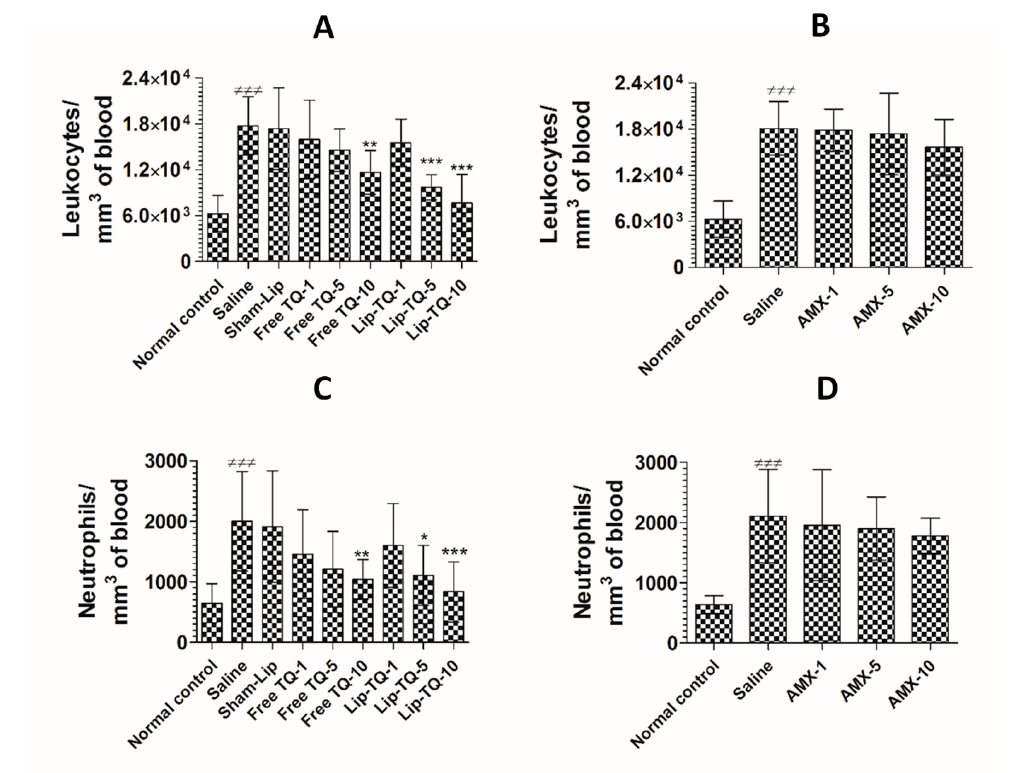
Figure 10. Treatment with Lip-TQ, but not with AMX, alleviated the parameters of total leukocytes and neutrophils in the mice infected with drug-resistant A. baumannii . On day 5 post-treatment, the blood was sampled from three mice and the leukocyte and neutrophil counts were analyzed. ( A ) Leukocytes in the free TQ- or Lip-TQ-treated mice, ( B ) leukocytes in the AMX-treated mice, ( C ) neutrophils in the free TQ- or Lip-TQ-treated mice, ( D ) neutrophils in the AMX-treated mice. The data are represented as the means ± SD of three independent experiments. (cid:54) = (cid:54) = (cid:54) = p < 0.001. Normal control vs. saline-treated mice, * p < 0.05, ** p < 0.001, *** p < 0.001. Saline vs. free TQ or Lip-TQ treatment